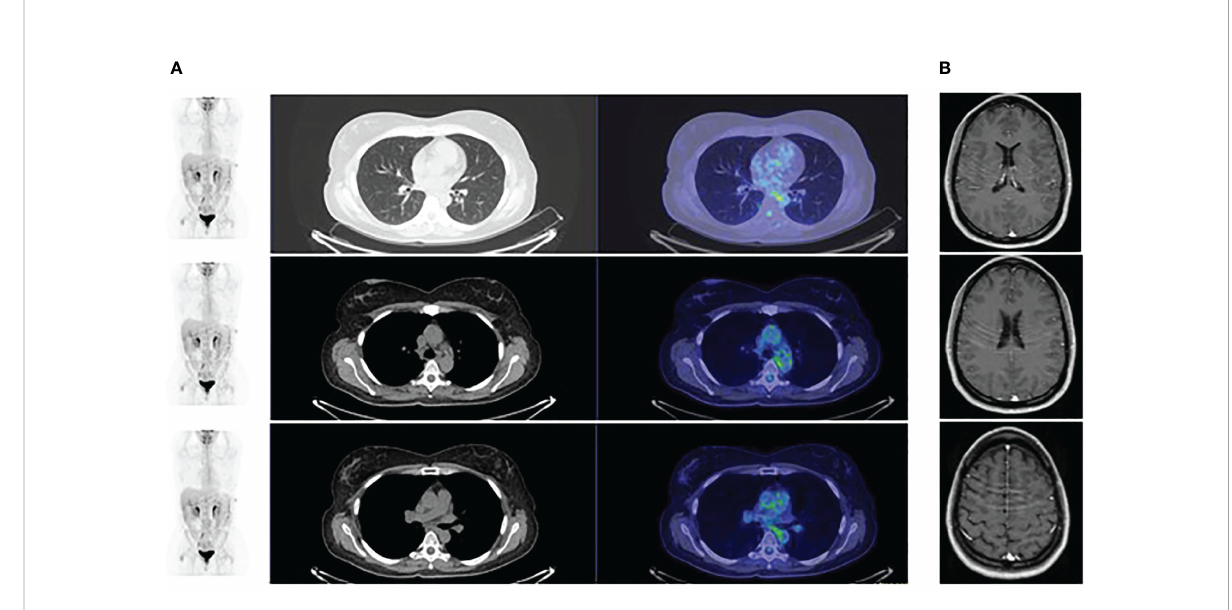
FIGURE 3 PET scan showing a partial response following 2 months of therapy.